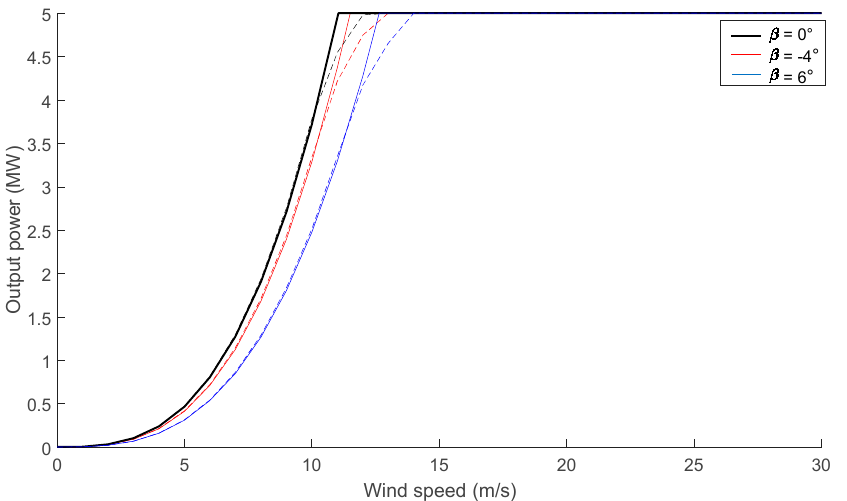
Figure 2. Generated power by the NREL 5 MW reference turbine depending on wind speed.